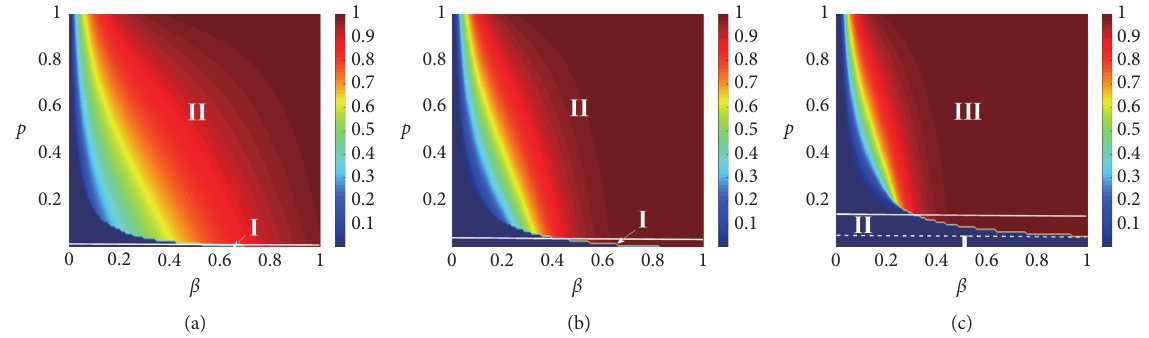
Figure 6: The joint effects of unit propagation probability β and the fraction of fashionable individuals p on the individual final adoption size for weighted SF network. Subgraphs (a, b, c) display the effects of ( β , p ) on the final adoption size with v � 2 . 1 , 3 , 4, respectively. There emerge two regions in (a) and (b): discontinuous phase transition in region I and continuous phase transition in region II. (c) Three regions: no global behavior outbreak in region I, discontinuous phase transition in region II, and continuous phase transition in region III. Other � 0 . 005, α � 2, T � 1, and T � parameters are ρ p q ω 0